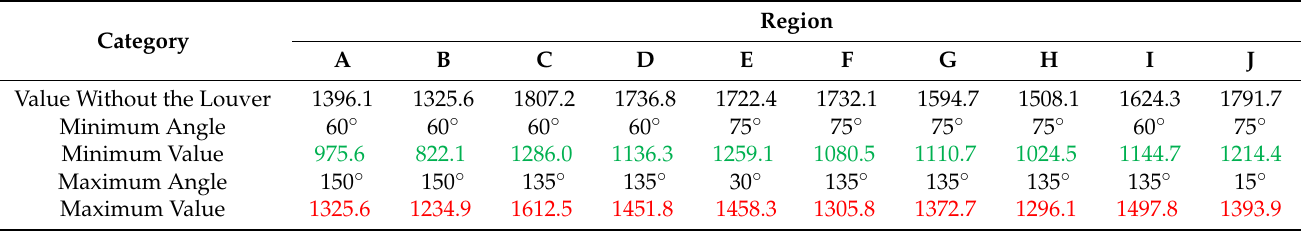
Table 9. Annual total thermal energy